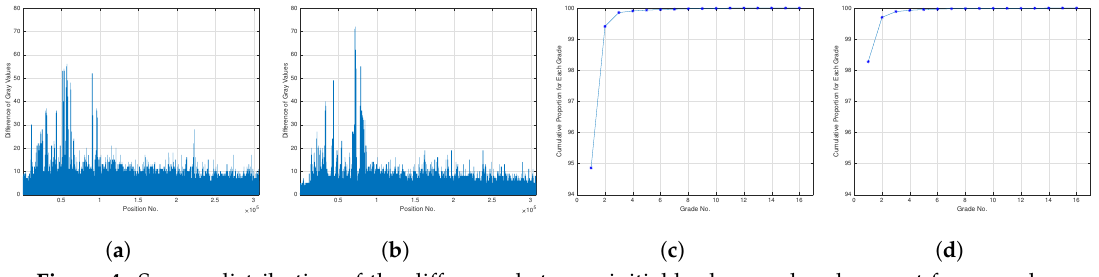
Figure 4. Square distribution of the difference between initial background and current frame and relevant cumulative distribution. ( a , b ) The difference distribution of gray values for each selected frames. ( c , d ) The cumulative distribution for each